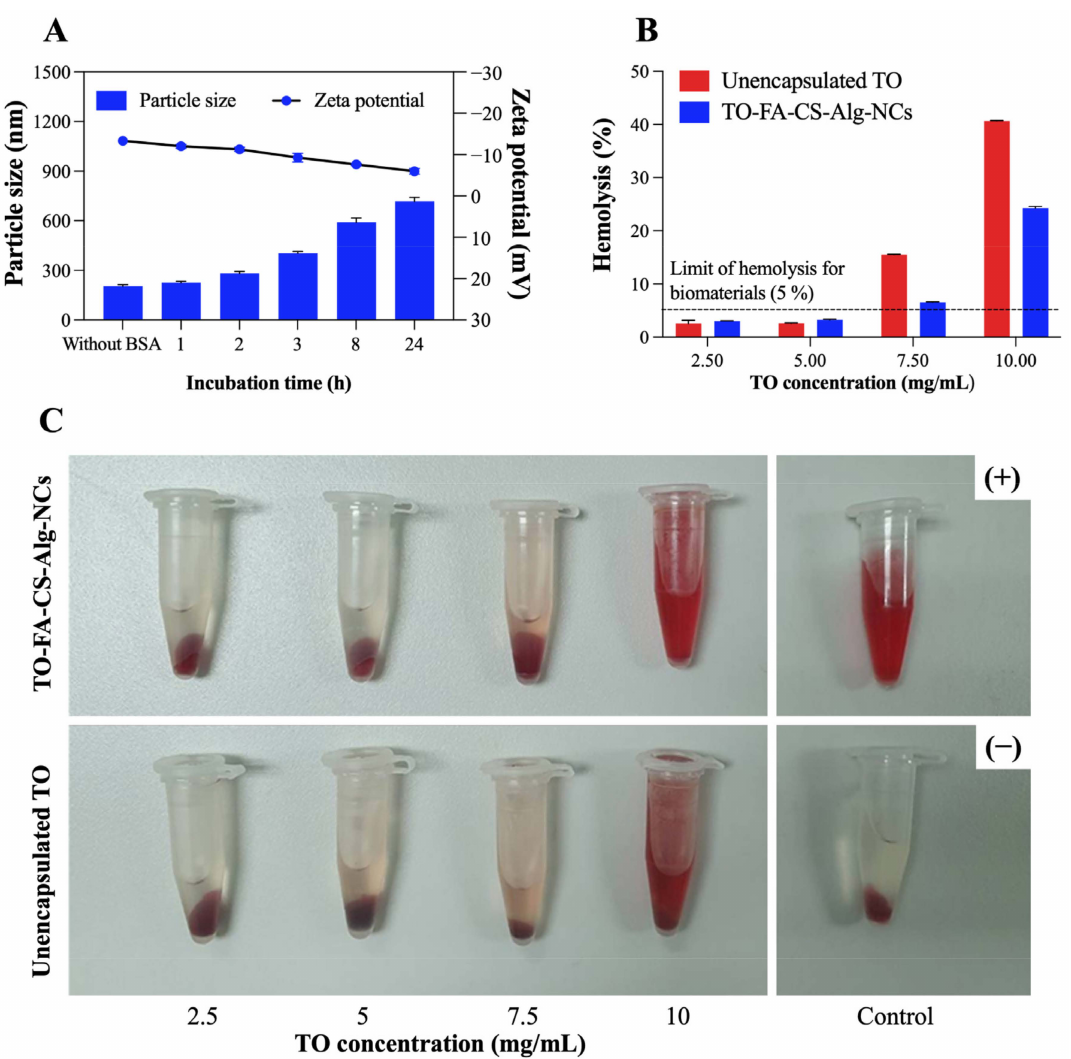
Figure 6. ( A ) The change in particle size and zeta potential of TO-FA-CS-Alg-NCs after 1–24 h incu- bation with BSA at 25 ◦ C; In vitro hemolysis assay of TO-FA-CS-Alg-NCs and free TO; ( B ) hemolysis percentage of different TO concentrations; ( C ) Images of RBC treated with TO-FA-CS-Alg-NCs and free TO. Data are expressed as mean ± SD (n =